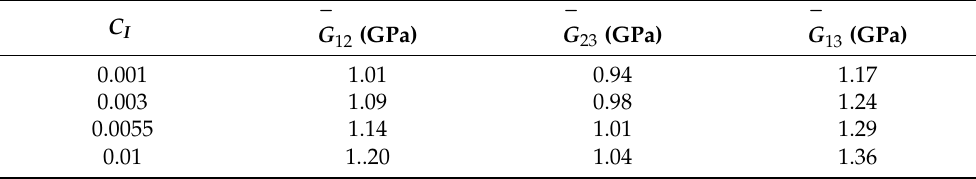
Table 3. Computed mean shear elastic constants of 13 wt.%. CF/ABS deposited bead. ¯ C I G 12 (GPa)